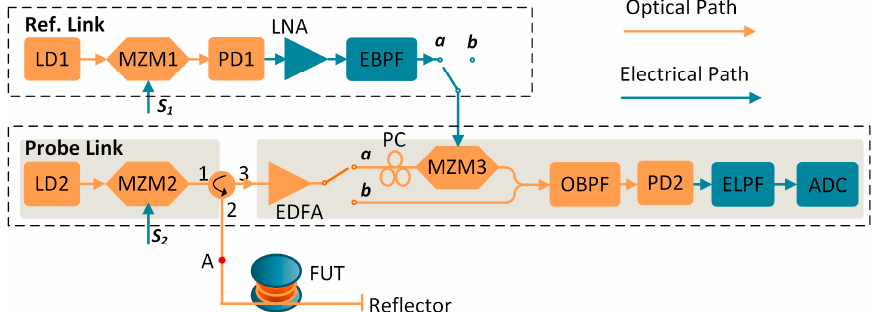
Figure 2. The schematic diagram of the proposed time delay measurement system. LD, laser; MZM, Mach–Zehnder modulator; EDFA, erbium-doped fiber amplifier; PD, photodetector; PC, polarization controller; LNA, low-noise amplifier; EBPF, electrical band-pass filter; ELPF, electrical low-pass filter; OBPF, optical band-pass filter; ADC, analog-to-digital converter.